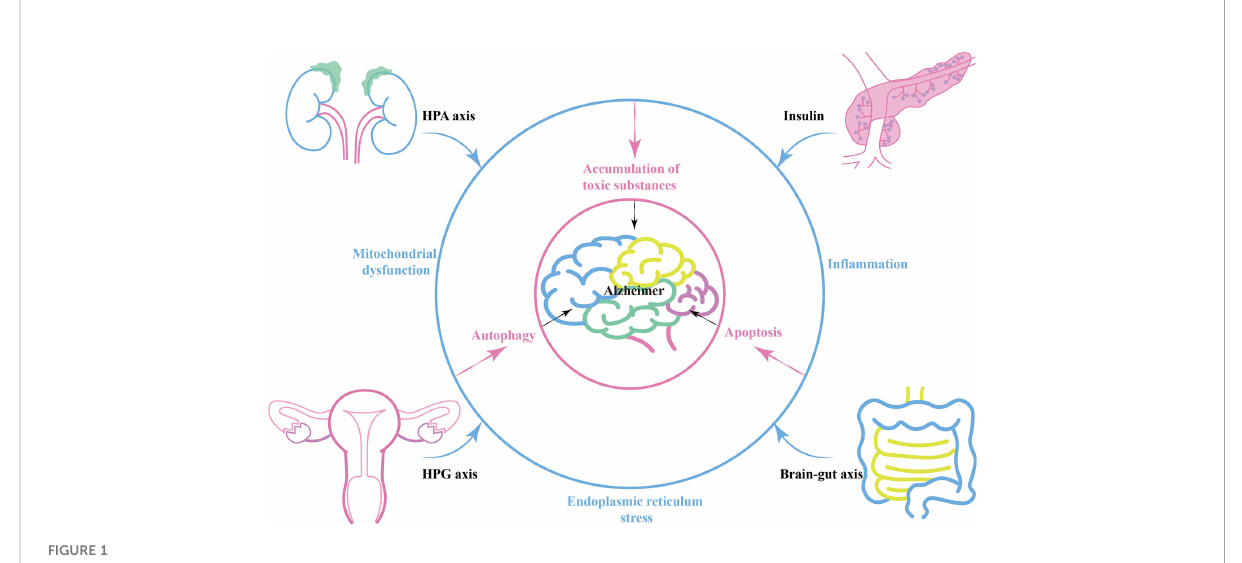
FIGURE 1 The relationship between neuroendocrine and Alzheimer's